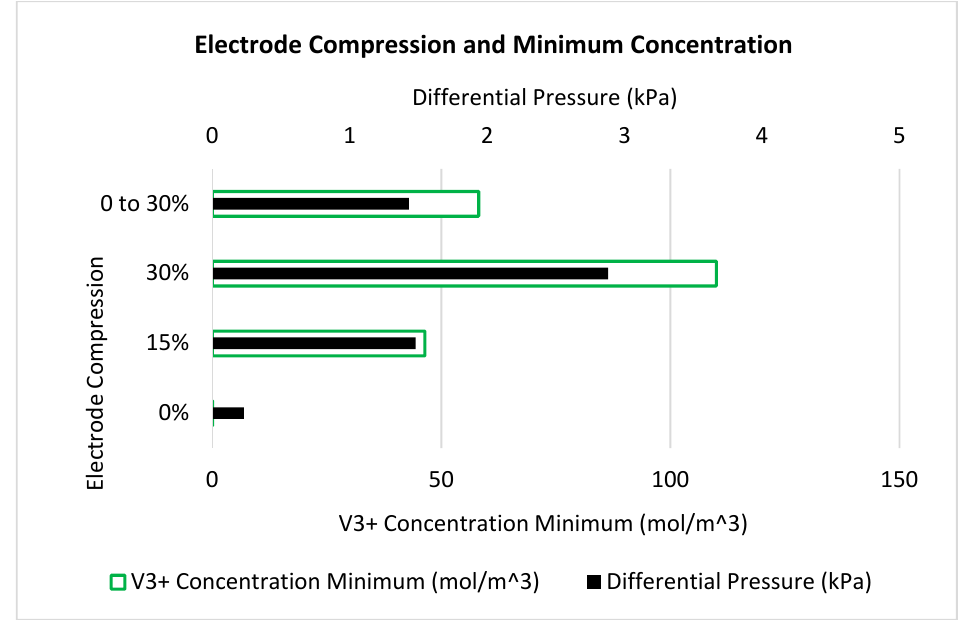
Figure 3. Minimum V 3+ reactant concentration (mol m − 3 ) and differential pressure (kPa) for Cases 1 to 4 showing the improvement delivered by variable reducing compression.